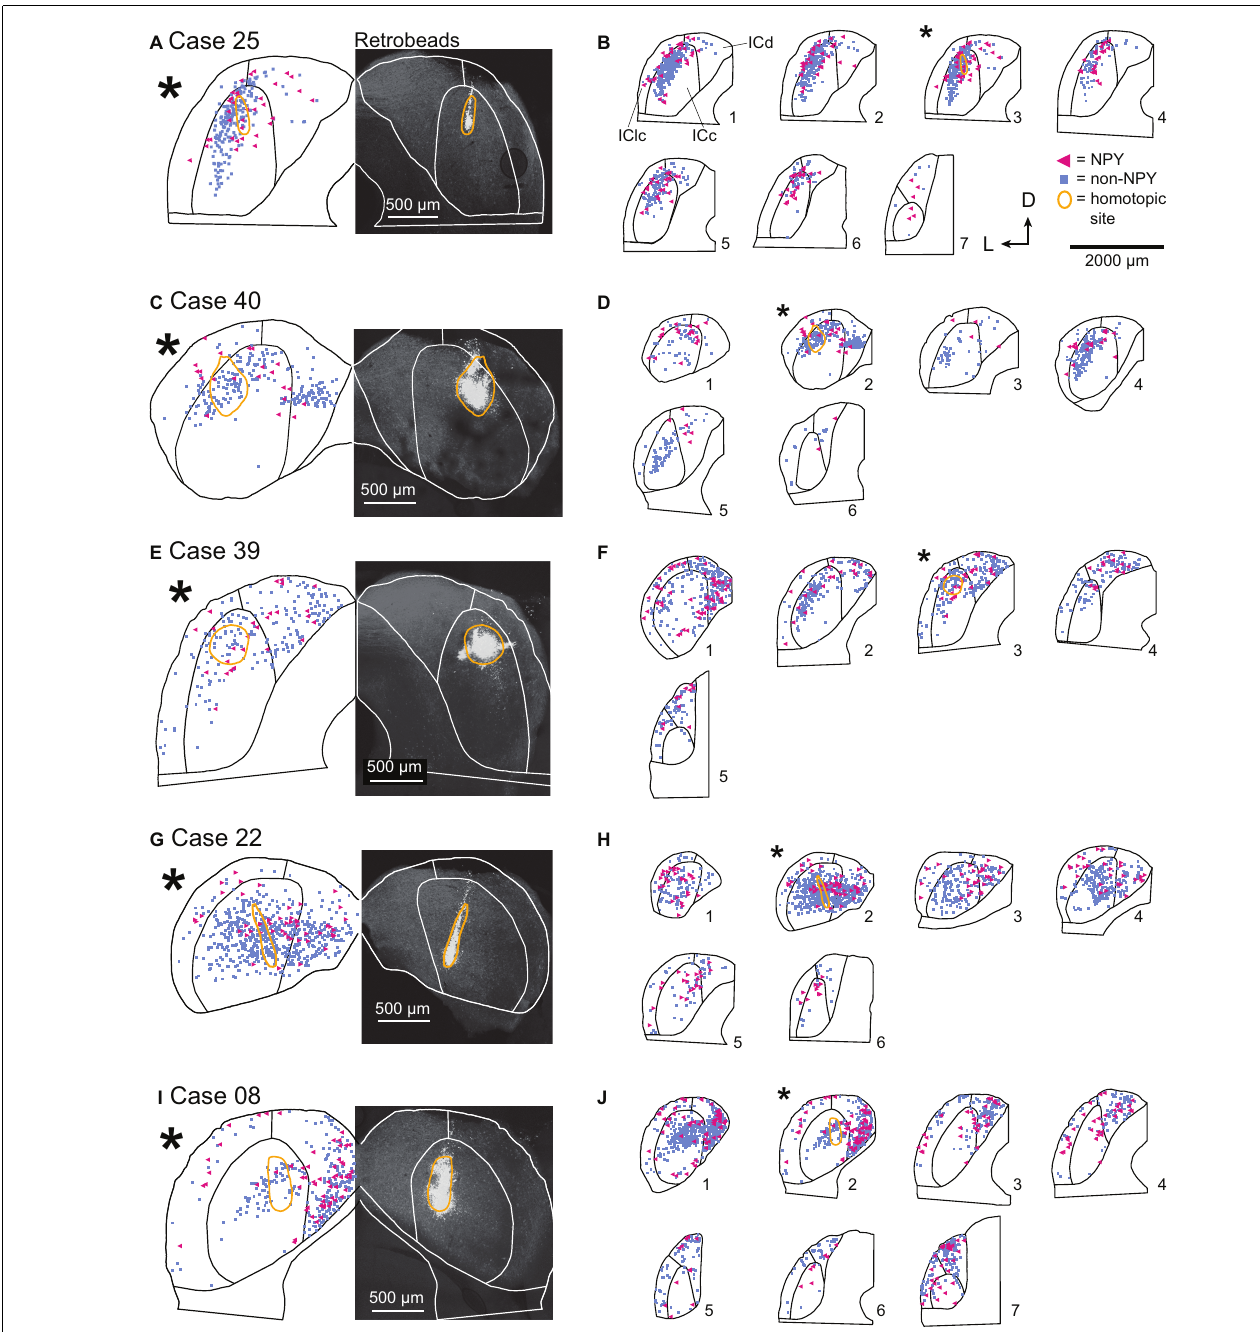
FIGURE 3 | In the ICc, commissural projections of NPY neurons are more heterotopic than those of non-NPY neurons. The panel shows results from five cases where injections were predominately limited to the ICc. (A) RB deposit site in the right IC and homotopic site in the left IC in experimental Case 25. The right half of the panel includes a gray-scale image showing the center of the RB deposit (circled in gold). The left half of the panel shows an outline of the left IC with the homotopic location of the injection site indicated by a reflected image of the gold outline. The illustrated section (*) is from a series of sections shown in (B) . (B) The full series of plots for Case 25 showing the distributions of RB-labeled (commissural) neurons that were NPY+ (magenta triangles) or non-NPY (cyan squares). Sections are numbered from caudal to rostral in each series. The asterisk indicates the section shown in (A) with the area homotopic to the injection outlined in gold. D—dorsal; L—lateral. (C–J) Results from four additional experimental cases, displayed as in (A,B) . The locations of the RB deposits in the ICc varied across cases, but the differences in distributions of NPY vs. non-NPY commissural cells were consistent: the NPY cells were less focused in the homotopic site.The main pattern of non-NPY neuron labeling in the ICc was often consistent with the shape of a frequency band, while NPY+ neurons were more common in regions bordering the frequency band. (B) n = 898 non-NPY neurons, 168 NPY neurons. (D) n = 573 non-NPY neurons, 86 NPY neurons. (F) n = 782 non-NPY neurons, 135 NPY neurons. (H) n = 1,095 non-NPY neurons, 161 NPY neurons. (J) n = 1,172 non-NPY neurons, 226 NPY neurons.